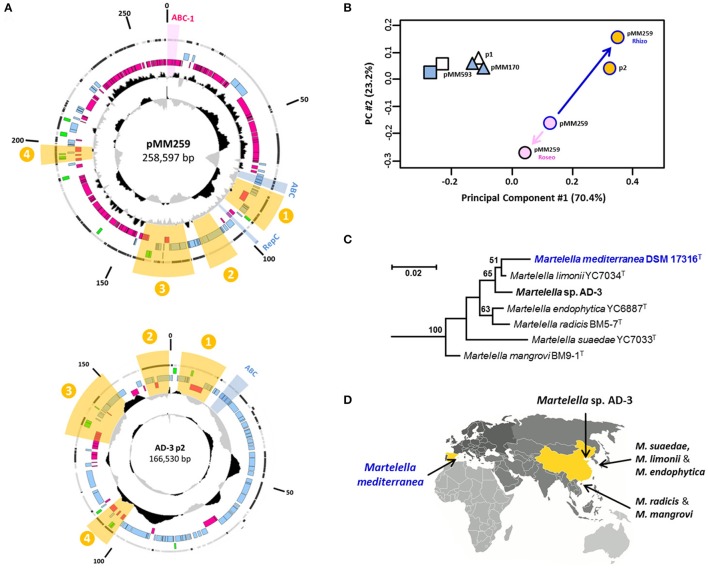
Comparison of plasmids from M. mediterranea DSM 17316T and Martelella sp. AD-3. (A) Circular maps of pMM259 and p2. Syntenous regions are highlighted with yellow sectors. (B) RSCU analysis; rhizobial and rhodobacteral parts of pMM259 were investigated separately. (C) 16S-rRNA gene analysis of all six type strains and the isolate AD-3 of the genus Martelella. (D) Provenance of Martelella strains based on the place of isolation.